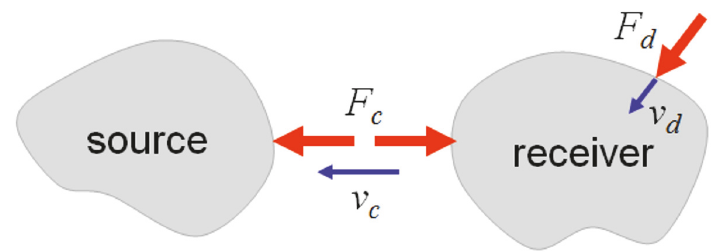
Figure 13: System